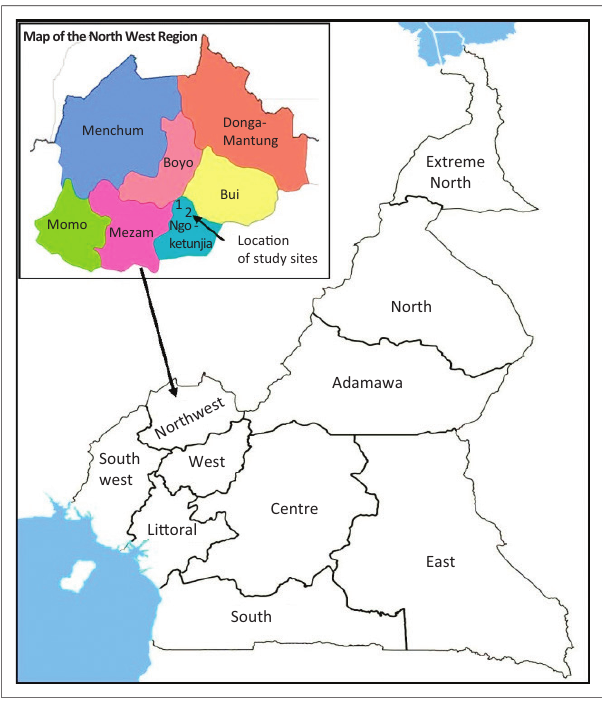
FIGURE 1: Cameroon map showing the study sites (1 – Babessi-Flood I; 2 – Baba I-Flood II) in Ngoketunjia division of the Northwest